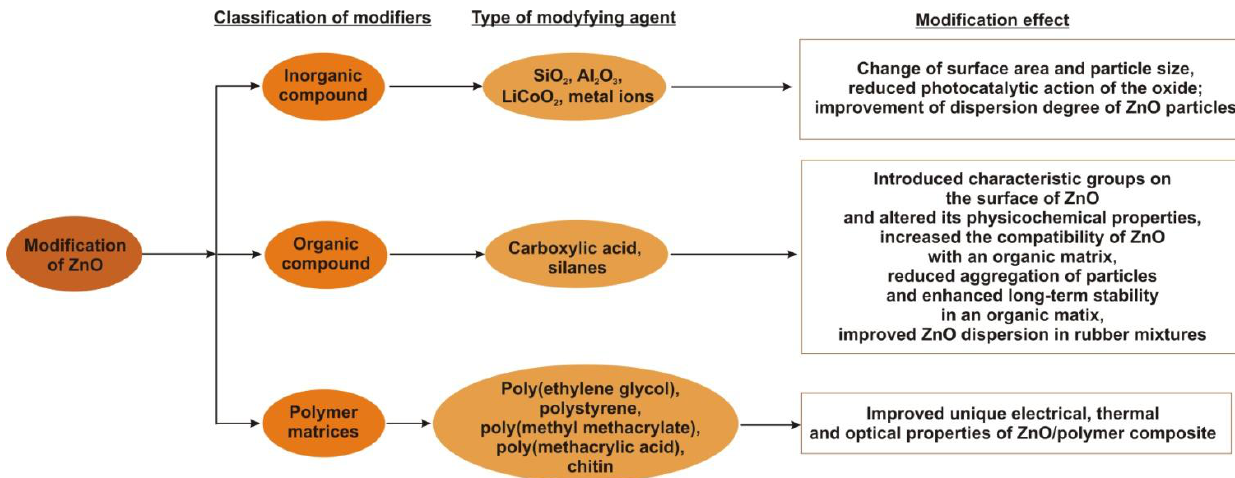
Figure 6. Schematic diagram of the most popular modifying methods of ZnO.